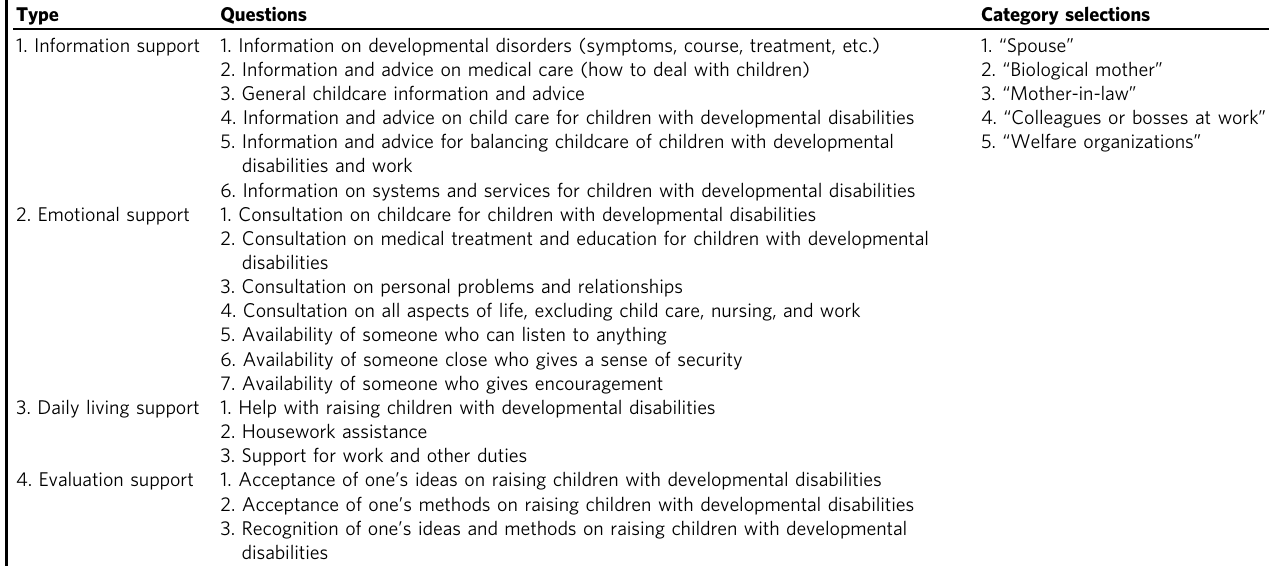
Table 1 Types of support and questions in the